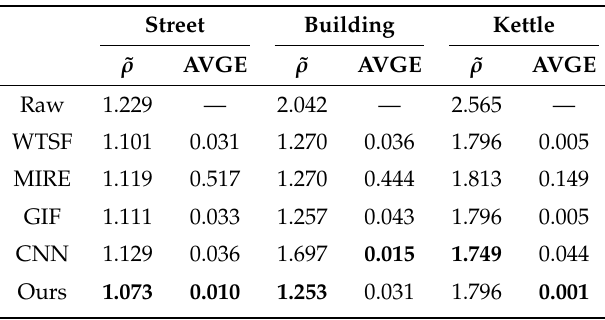
Table 4. ˜ ρ and AVGE results for raw IR